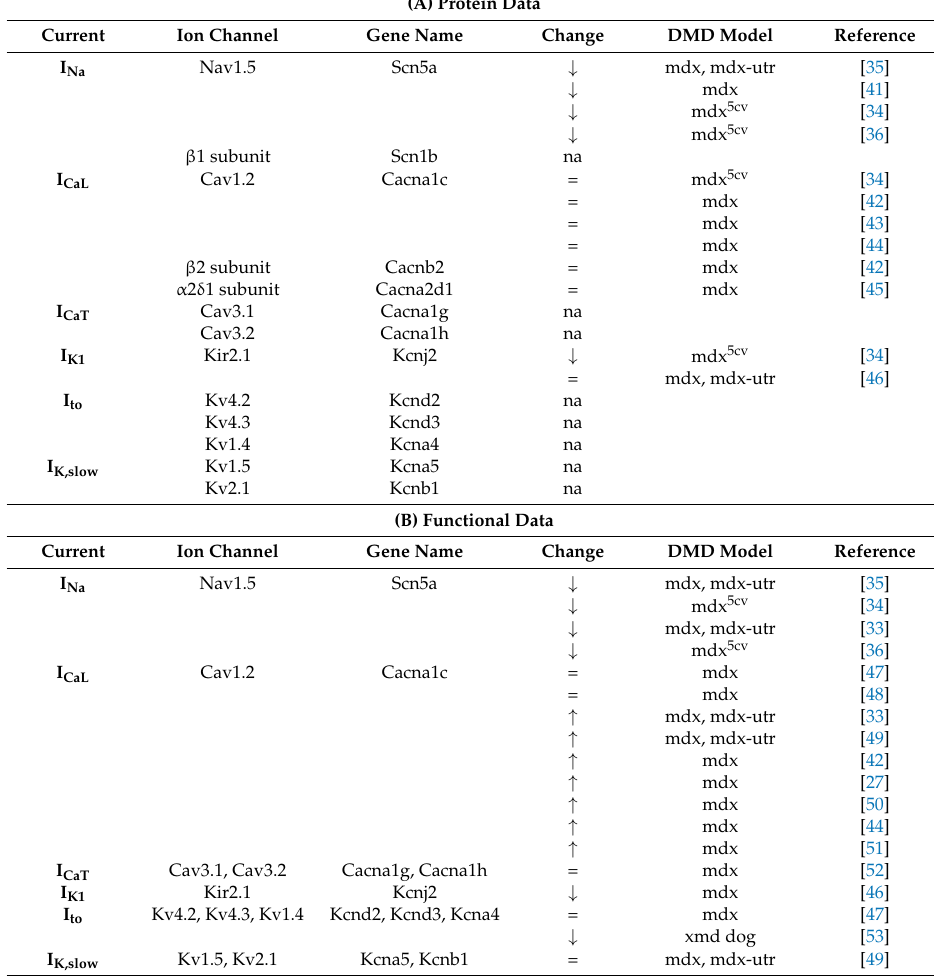
Table 1. Dystrophin deficiency—induced changes in the properties of cardiac ion channels at the level of protein expression ( A ) and channel function ( B ). Arrow heads pointing towards the bottom indicate a down-regulation of channel protein expression ( A ), or a channel loss-of-function ( B ). “=” represents no change in channel expression ( A ) or function ( B ). Arrow heads pointing towards the top indicate an up-regulation of the channel protein expression ( A ), or channel gain-of-function ( B ). na (not available) implies that it is currently unknown if dystrophin deficiency induces any changes in the expression of the respective channel protein. I Na —Na 2+ current; I CaL —L-type Ca